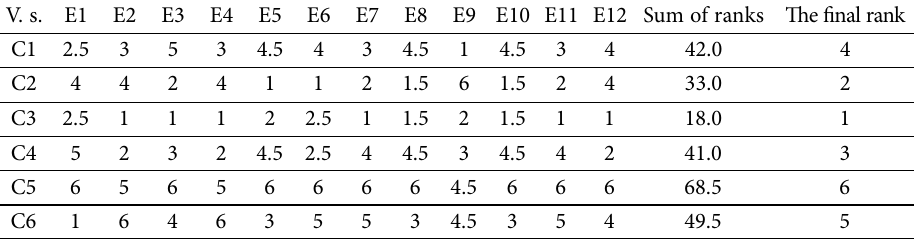
Table 4. Ranking factors in the group of a financial environment regarding the commercial potential of technologies